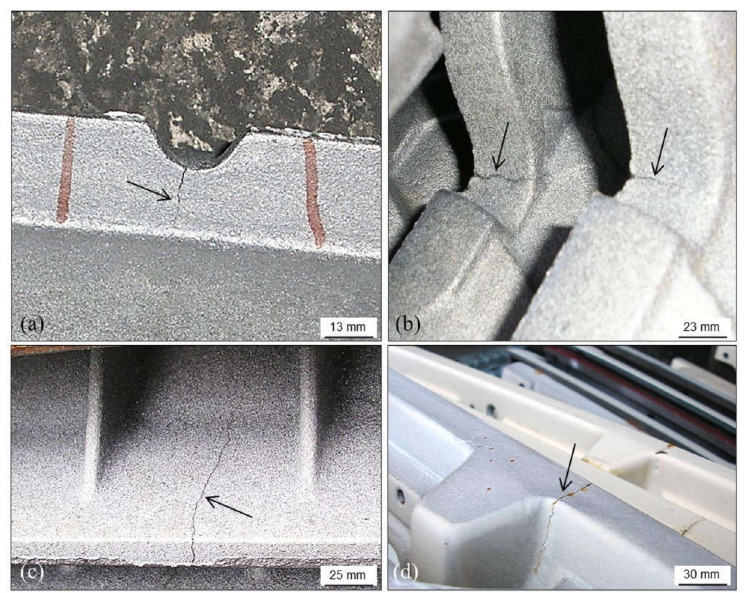
Figure 63. Different locations of hot tears found in some large extended grey iron castings ( a – d